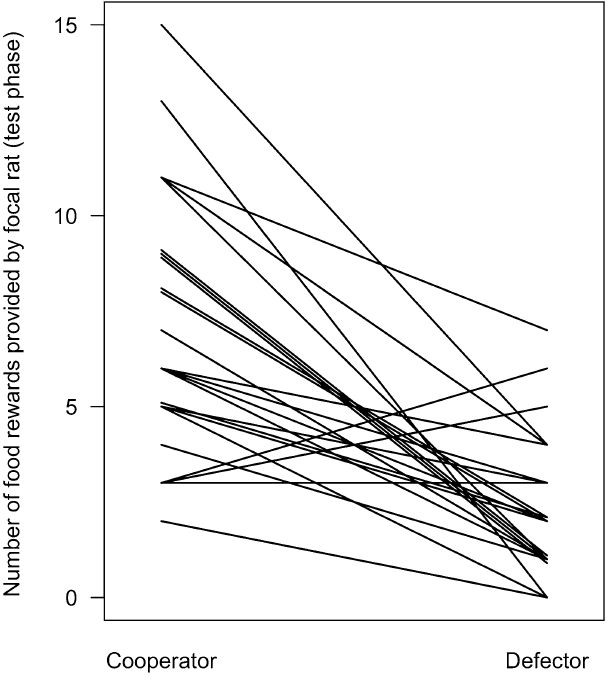
Figure 2. Total number of food rewards provided by focal rats to their cooperating and defecting partners. 21 out of 24 focal individuals provided food rewards more often to the previously cooperating than to the previously defecting partner. Every line represents the number of food rewards provided by one focal individual to its respective previous cooperator (left) and defector